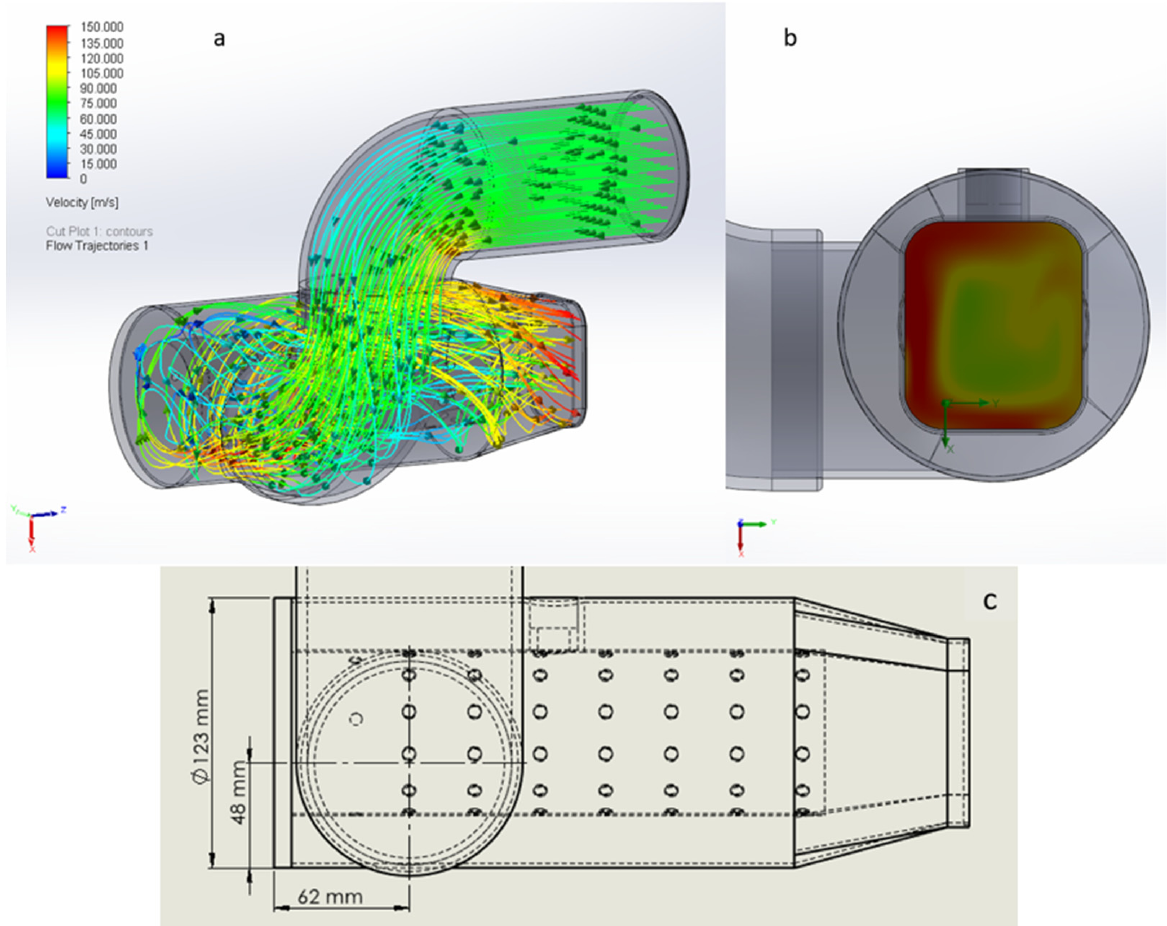
Figure 8. ( a ) The duct from the compressor is displaced at the bottom of the combustor, increasing the offset. In addition, the duct was displaced at the end of the combustor on the side of the fuel nozzle. ( b ) Velocity distribution of outflow. ( c ) Technical detail of bottom-end position for air pipe. The swirl is still improved as in the previous solution (Figure 7). In addition,